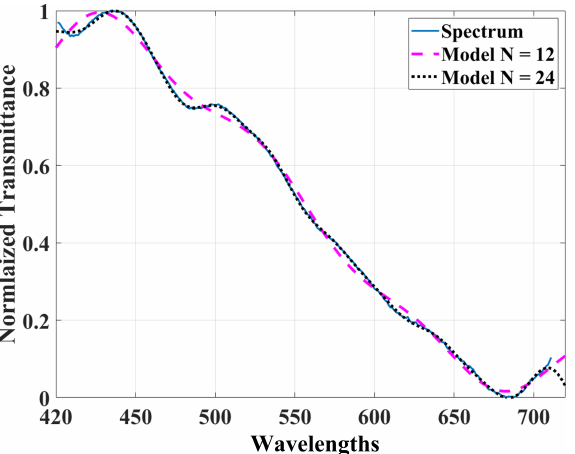
Figure 4. Adjust the measured transmittance spectrum from the GS images cube using the Sum of Sine functions. The segmented purple and black lines represent a fit using 15 and 24 coefficients that obtained an RMS of 0.016333 and 0.003743,